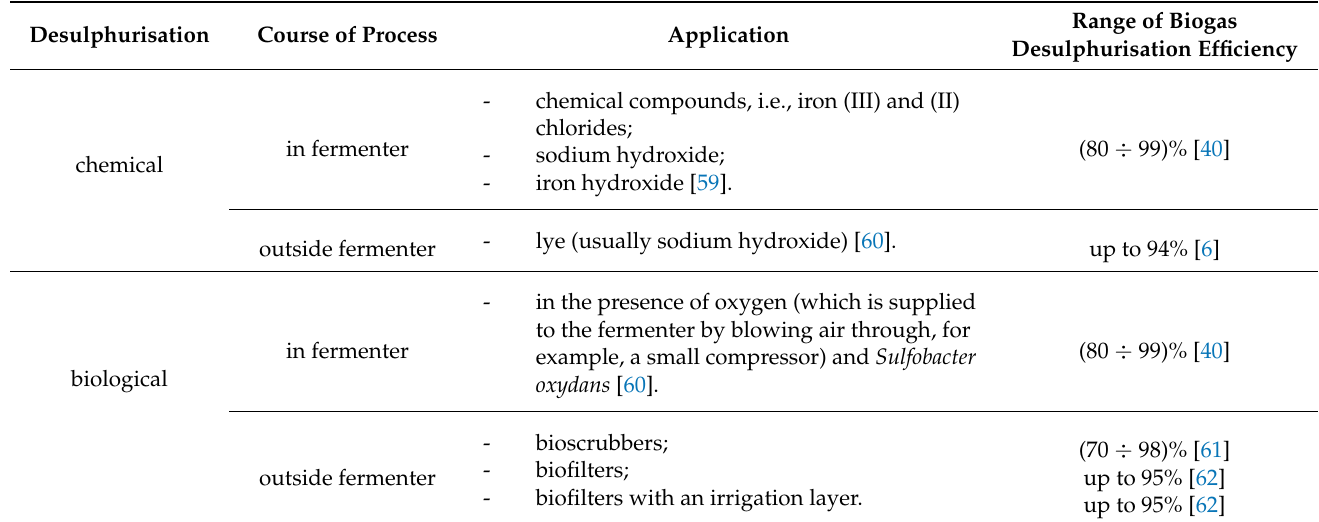
Table 2. Desulphurisation methods, especially for agricultural biogas due to the fermentation process.